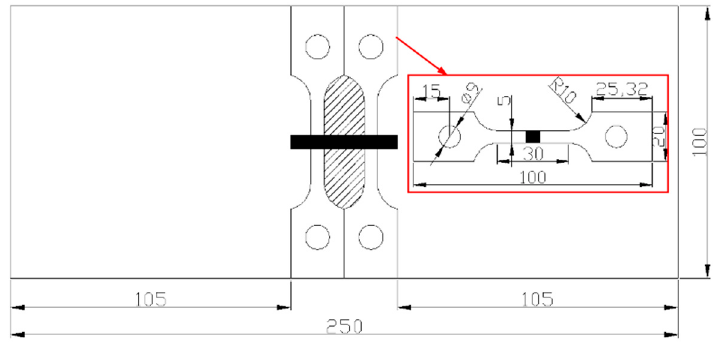
Figure 3. The processing position and geometry of slow strain rate test (SSRT) specimen.